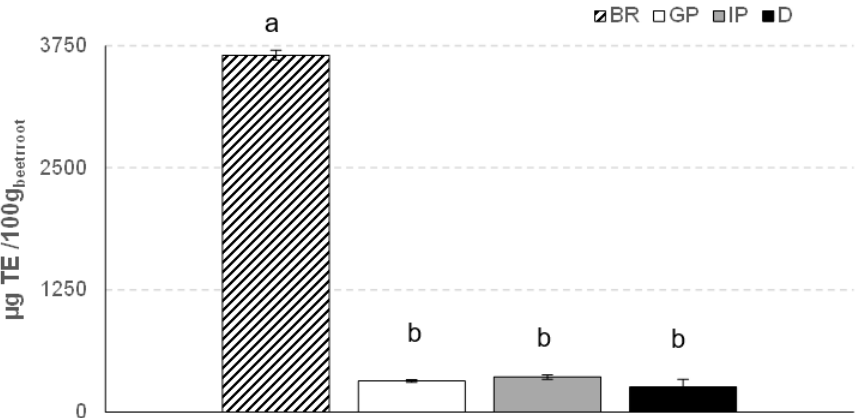
Figure 5. Antioxidant activity ( µ g TE/100 g fw of beetroot) of beetroot (BR), gastric phase (GP), intestinal phase (IP), and digested (D) sample. Different letters indicate significant differences ( p < 0.05) between samples.